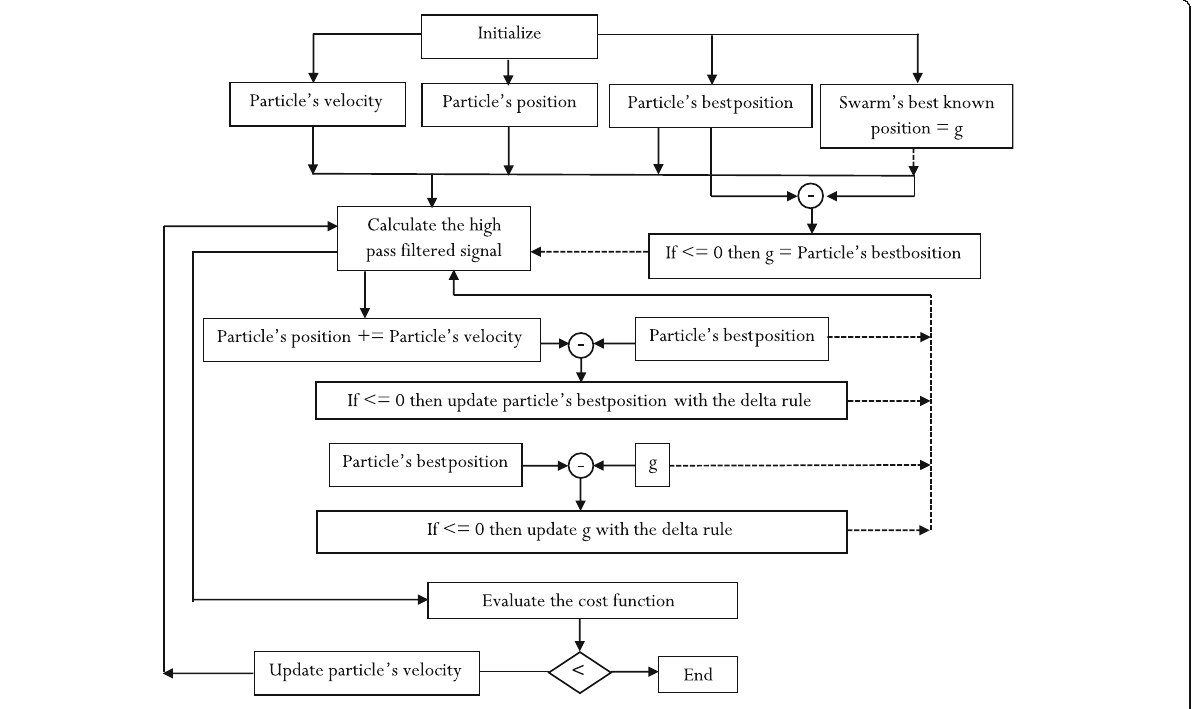
Fig. 12 A flowchart for the implementation of particle swarm